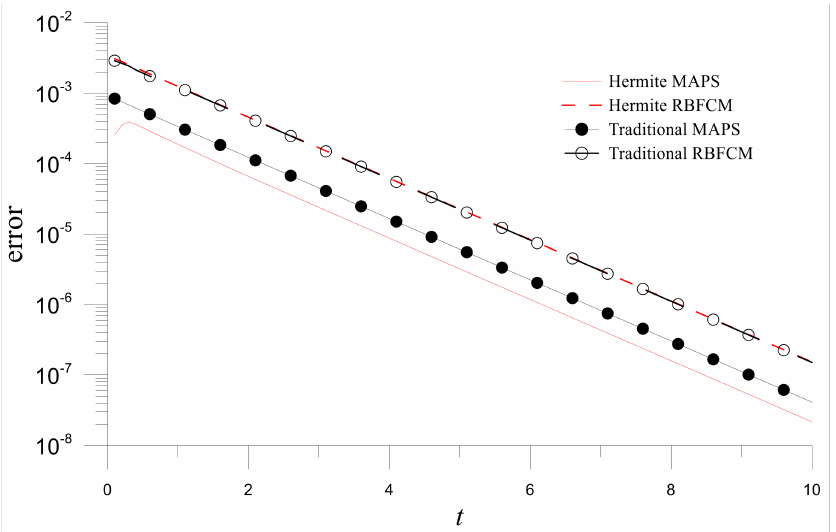
Figure 20. Time histograms of errors for numerical solutions obtained by the four methods in Example 5 ( ∆ t = 0.005, θ = 1 and N = 252